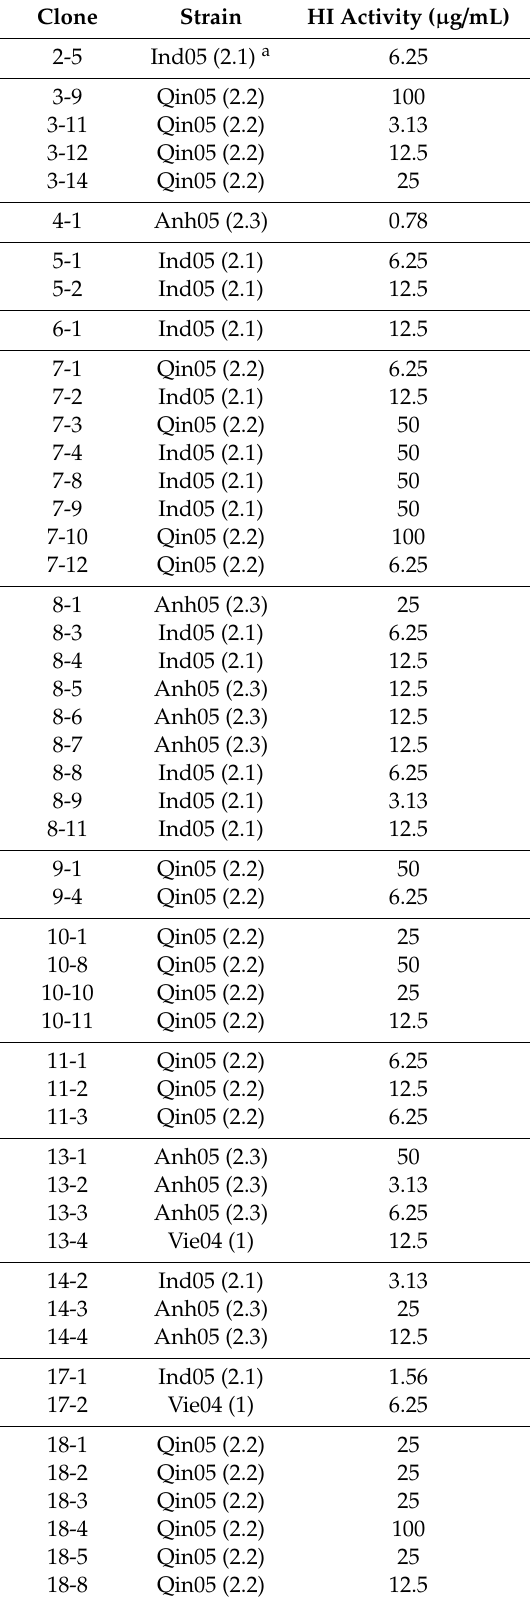
Table 2. Measurement of HI (hemagglutination inhibition)